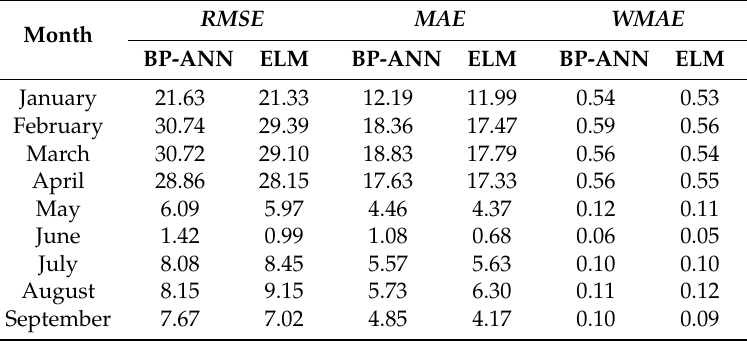
Table 4. Average performance metrics obtained by the developed BP-ANN model on the months of the test dataset, with respect to the proposed